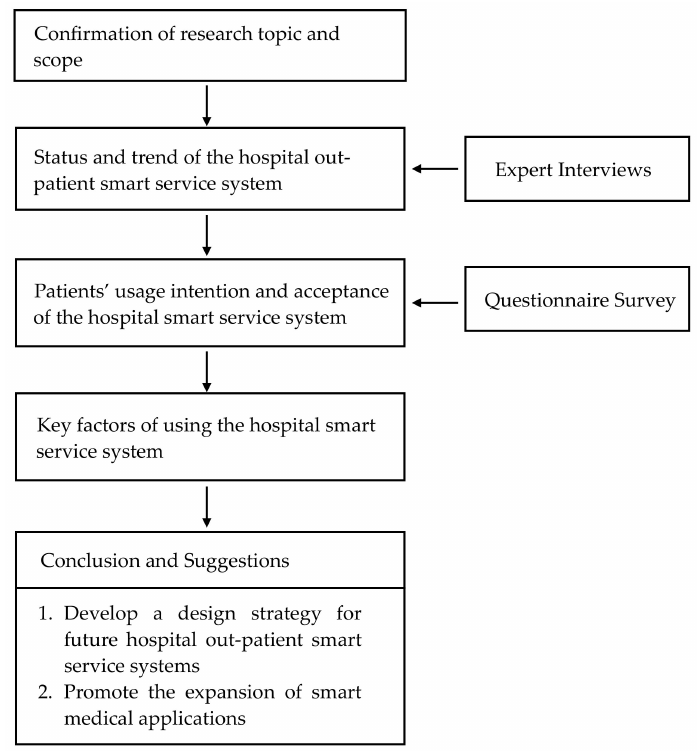
Figure 2. Research